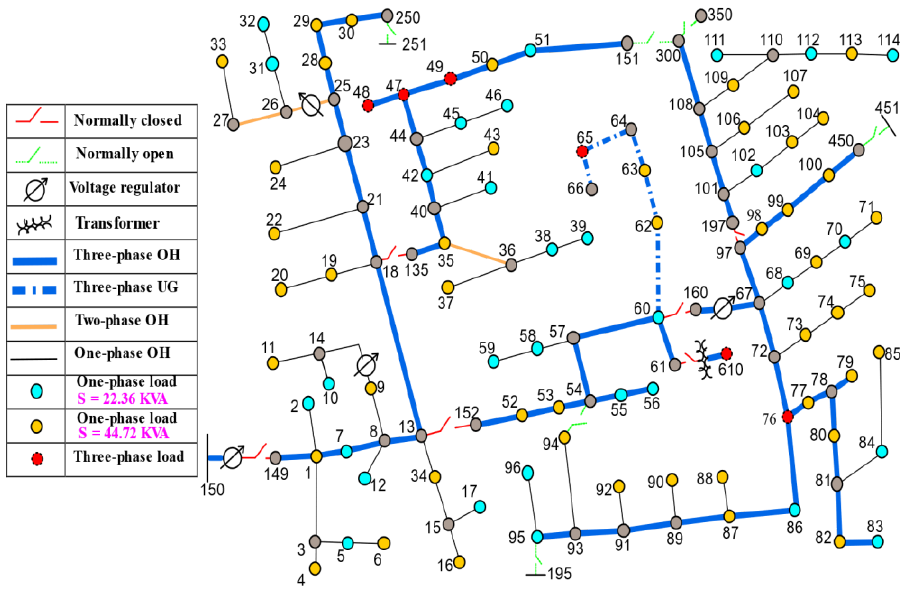
Figure 12. IEEE 123-node test feeder [37]. Algorithm 1. Estimation and Assessment of Smart and Uncontrolled Charging Profiles.